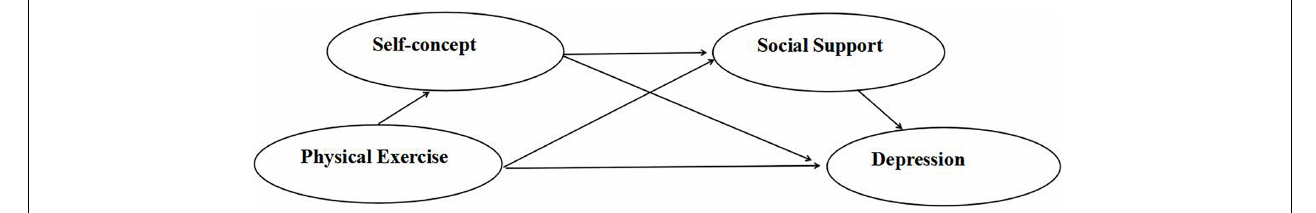
FIGURE 1 | The chain-mediated modle of self-cocept and social support.